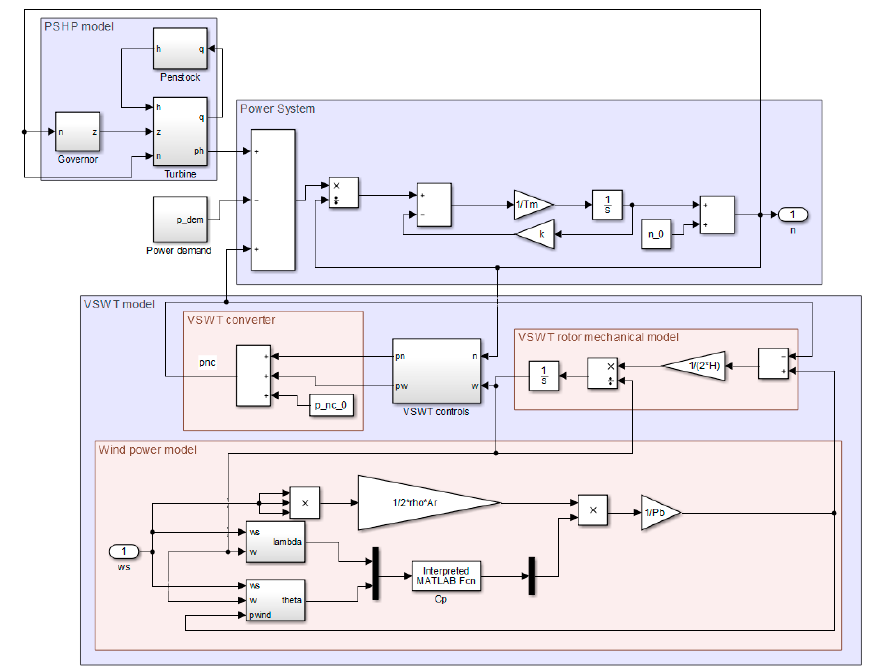
Figure 1. Block diagram of the power system with a hybrid wind–hydro plant and the power system.